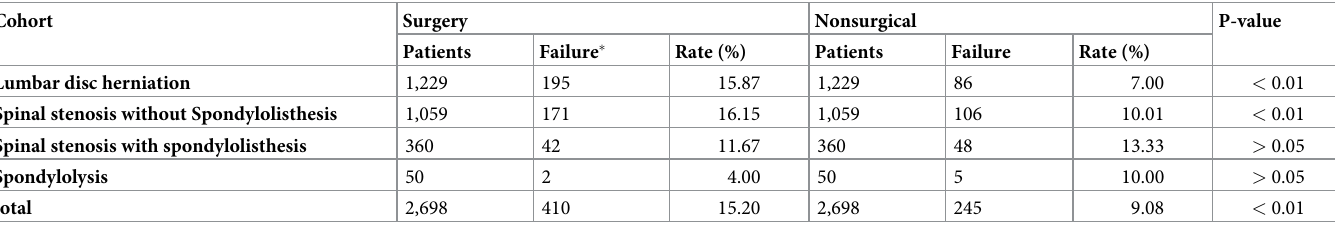
Table 5. Failure of treatment.